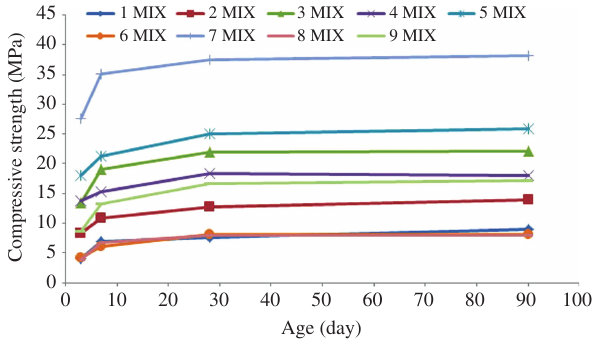
Figure 16 The effect of aging on geopolymer compressive strength for samples cured at 85 °